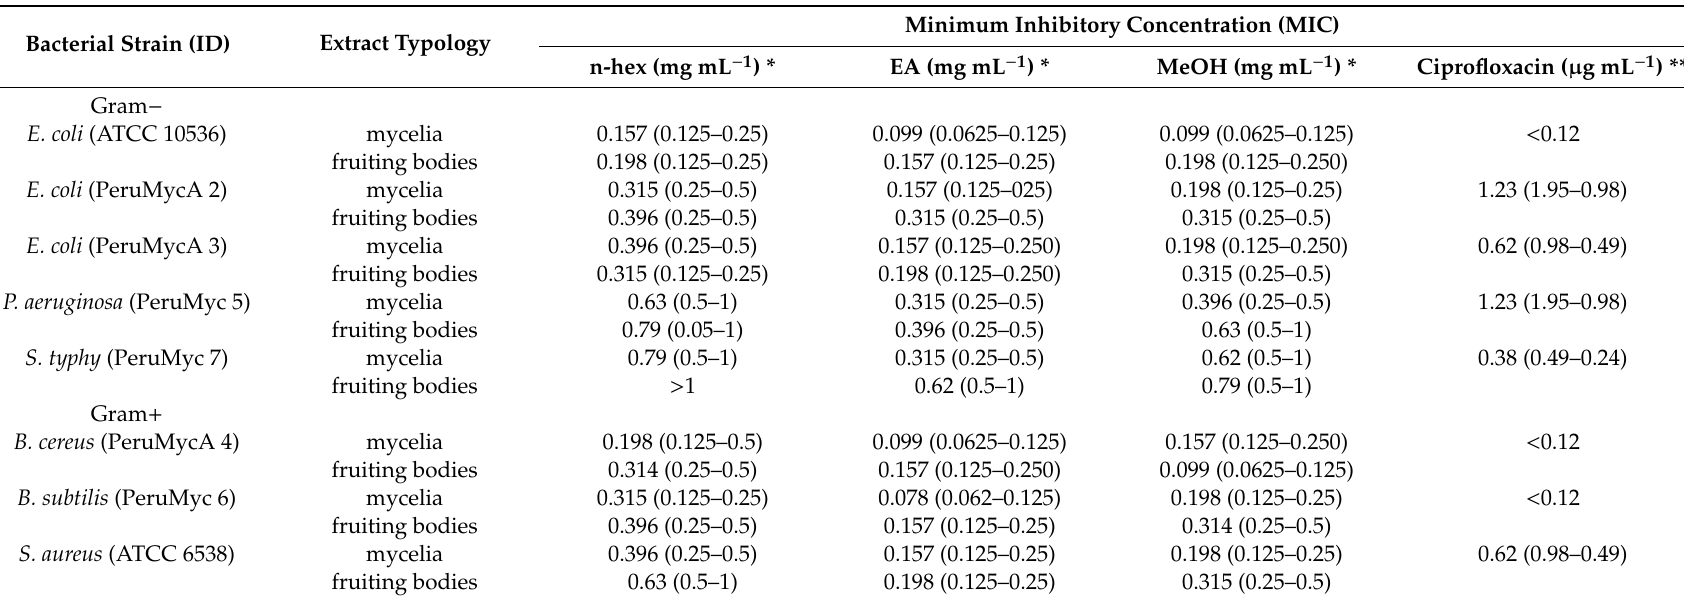
Table 4. Minimal inhibitory concentrations (MICs) of Tricholosporum goniospermum n-hexane, ethyl acetate and methanol extracts, and ciprofloxacin towards selected Gram-negative and Gram-negative